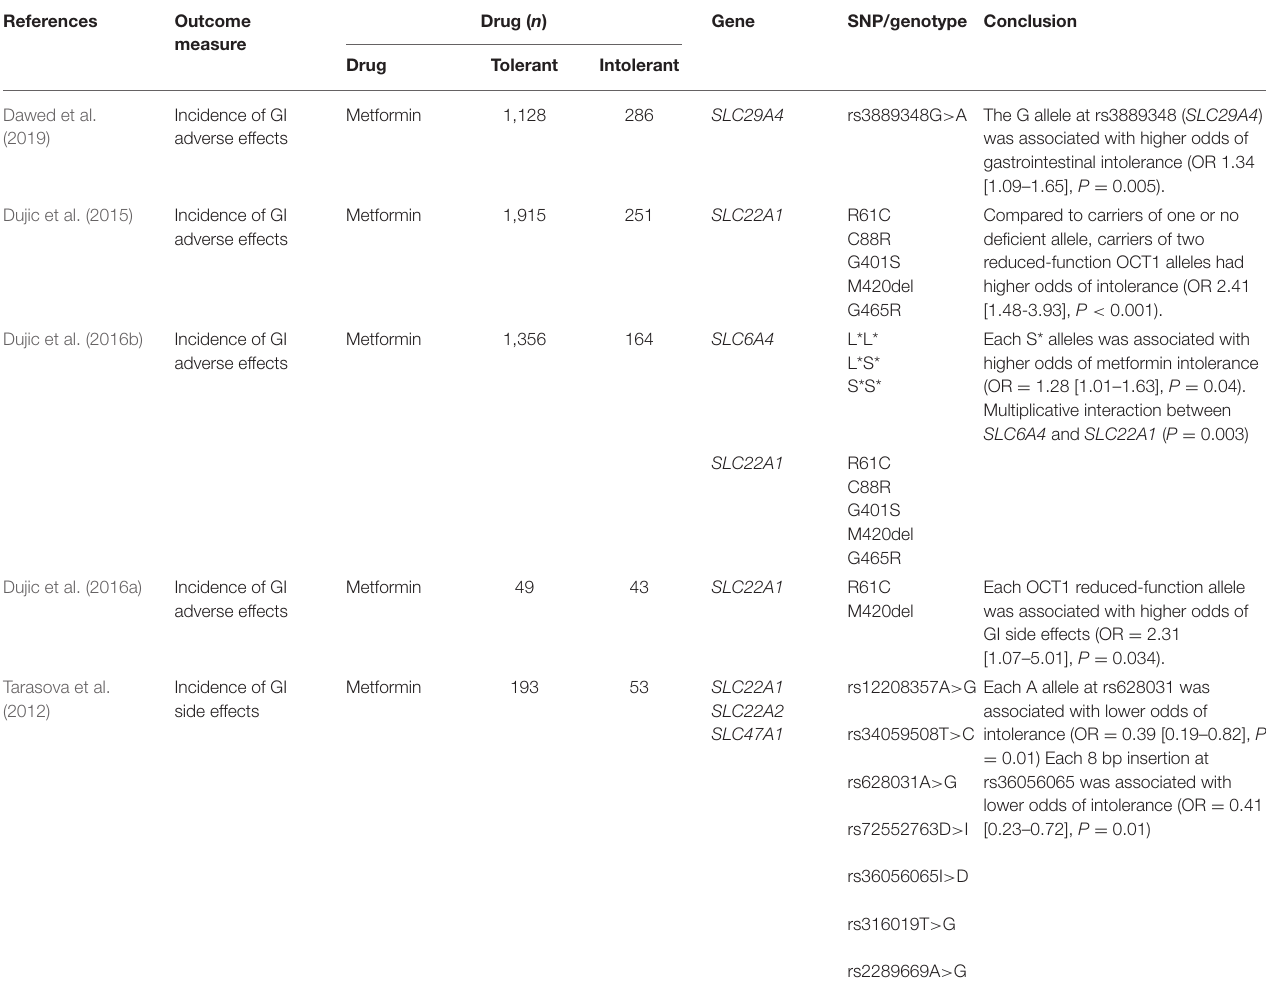
TABLE 3 | Association between metformin and selected SNPs for the incidence of GI adverse